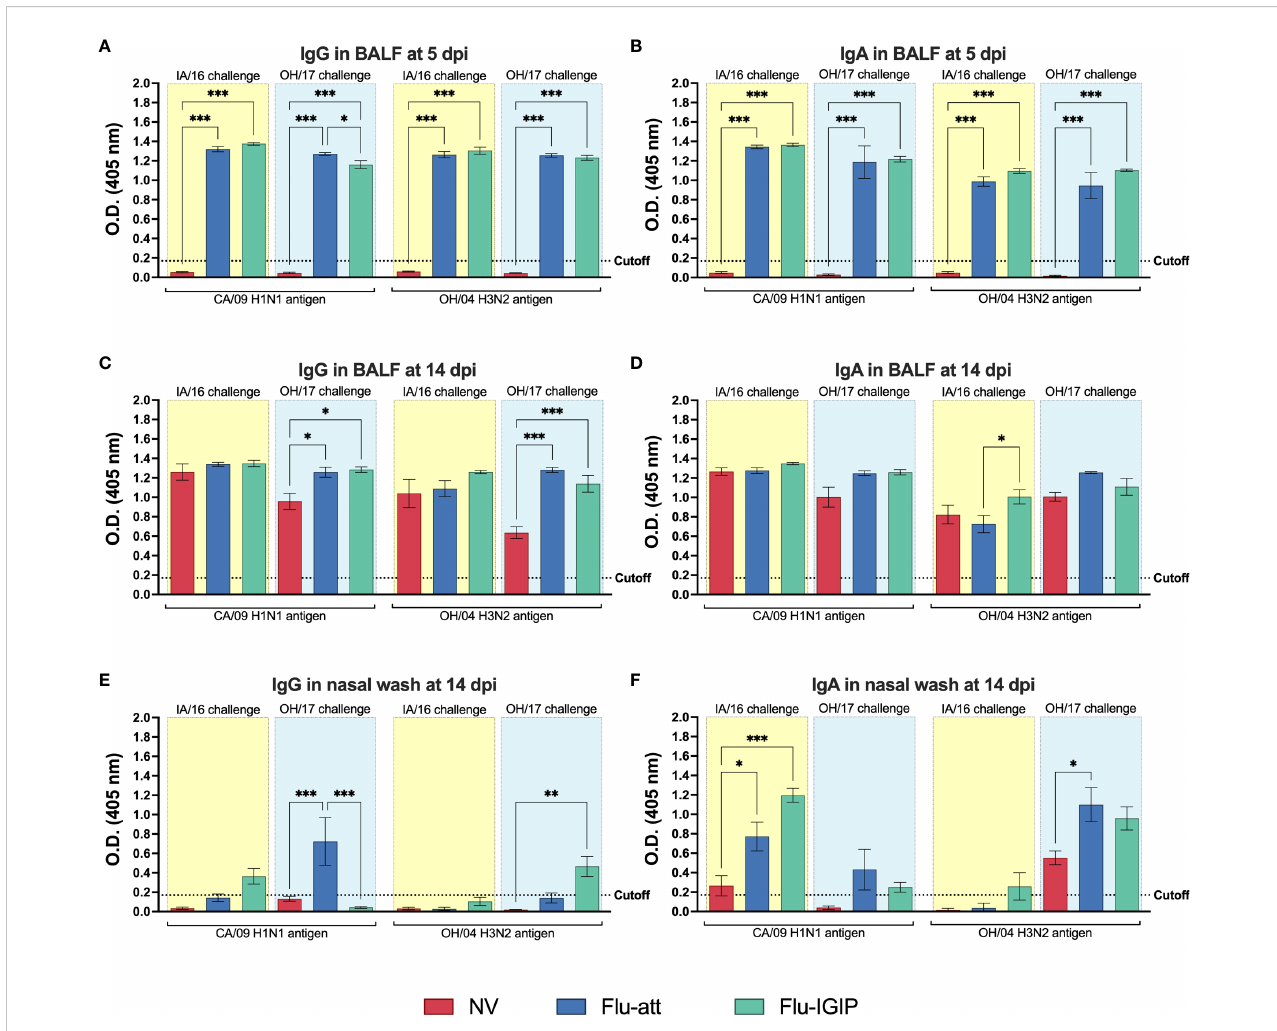
FIGURE 3 In fl uenza-speci fi c antibody response in mucosal surfaces after inoculation. Pigs were not vaccinated (NV, red bars) or vaccinated with bivalent Flu- att (blue bars) or Flu-IGIP (green bars) containing CA/09 H1N1 and OH/04 H3N2 viruses. Pigs were challenged with IA/16 H1N1 (light-yellow boxes) or OH/ 17 H3N2 (light-blue boxes) viruses. IgG levels were measured in bronchoalveolar lavage fl uid (BALF) at (A) 5 and (C) 14 days post inoculation (dpi) and in nasal wash at (E) 14 dpi. IgA levels were measured by ELISA in BALF at (B) 5 and (D) 14 dpi and in nasal wash at (F) 14 dpi. Viruses on the x-axis represent antigens used in the ELISA. Results displayed as means ± standard error of the mean. Dotted lines indicate assay cutoff values calculated as the average of negative pigs + 3 times the standard error of the mean for ELISA. *, p ≤ 0.05; **, p ≤ 0.01; ***, p ≤ 0.001 within groups challenged with same virus. CA/09, A/California/04/09; OH/04, A/turkey/Ohio/313053/2004; IA/16, A/swine/Iowa/A01778877/2016; OH/17,